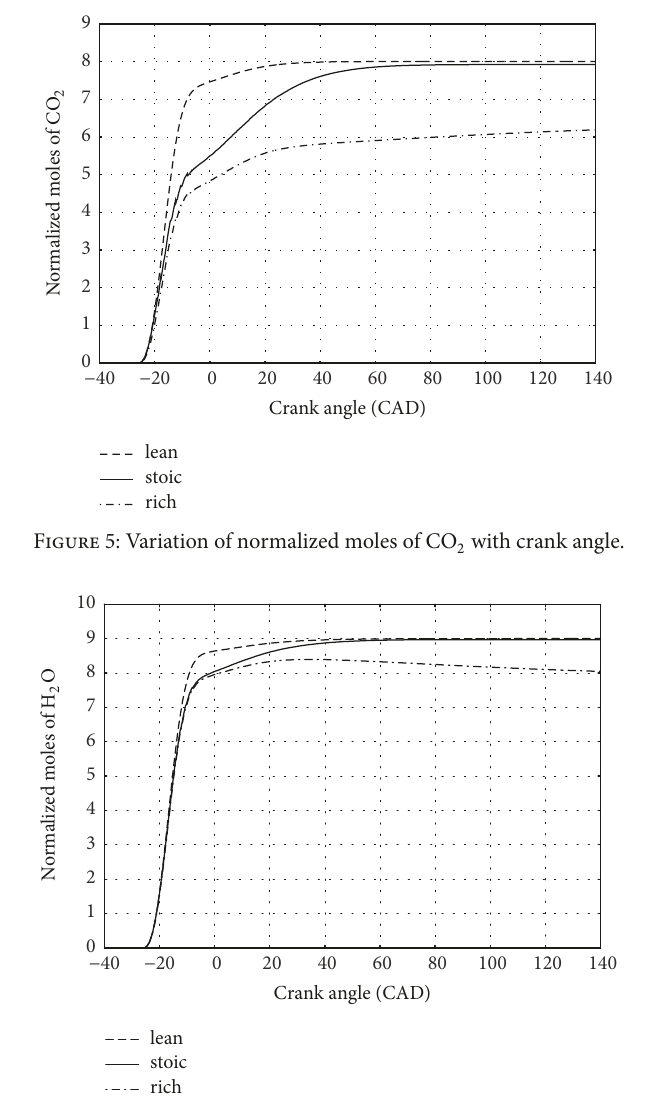
Figure 6: Variation of normalized moles of H 2 O with crank